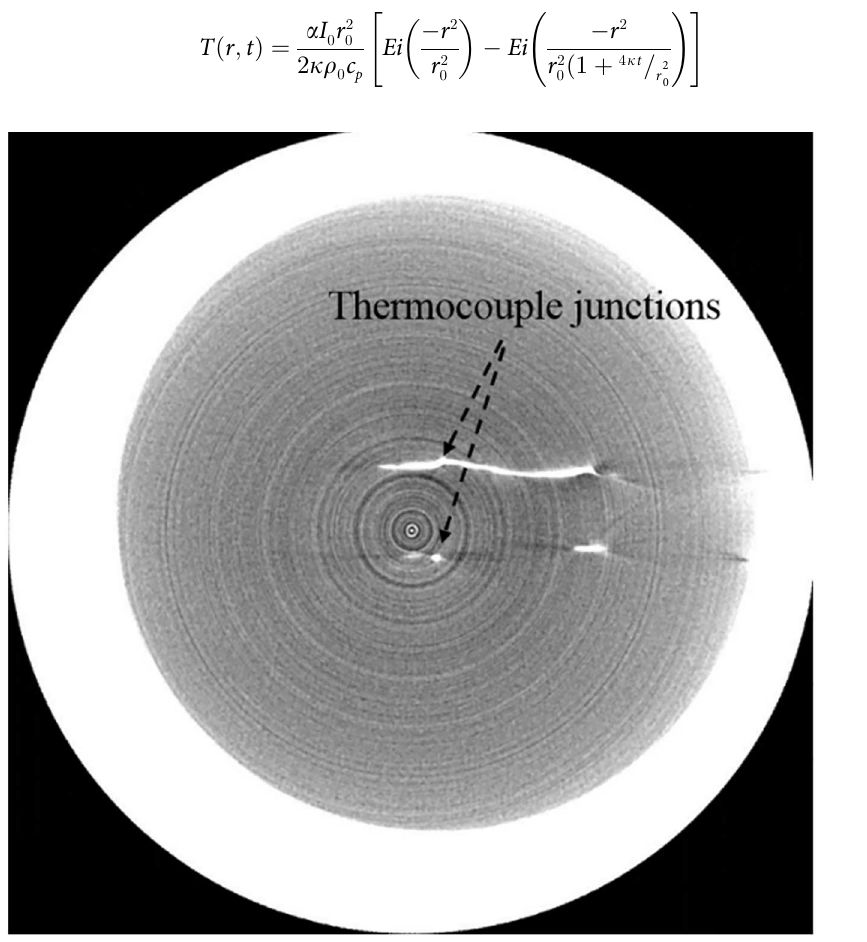
Fig 3. CT image of TCs within phantom. The bright spots representthe TC